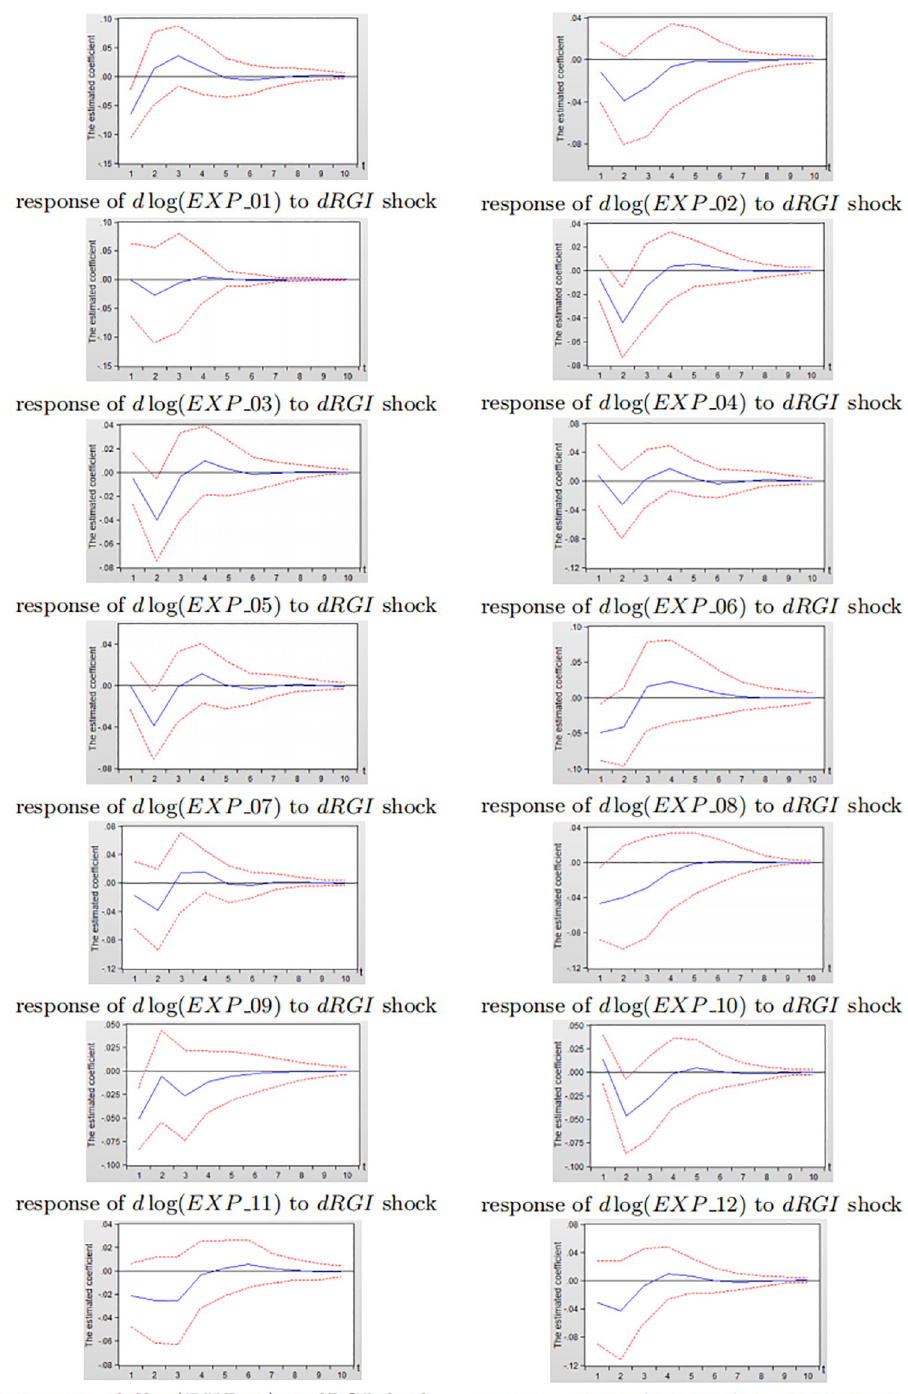
Fig 14. Impulse response diagram of reverse globalization to China’s sub-service exports.